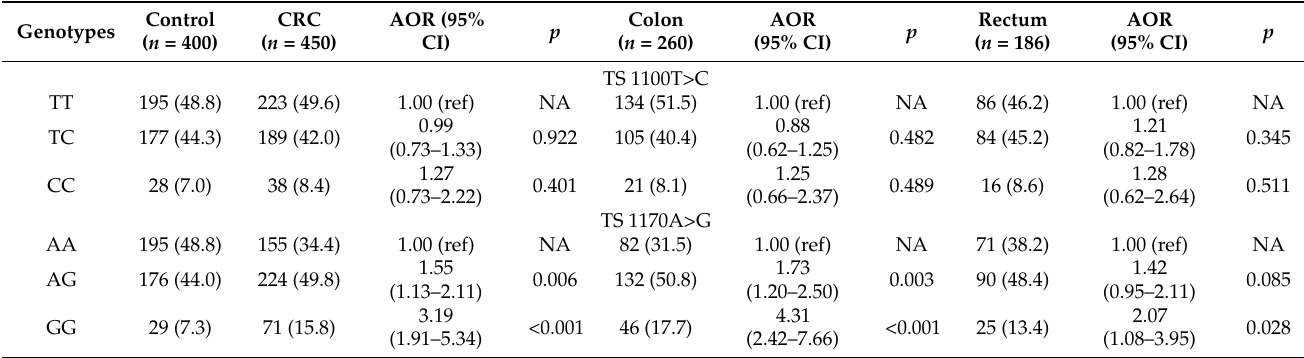
Table 2. Genotype frequencies of TS 3 (cid:48) -UTR polymorphisms between CRC patients and control subjects. Genotypes